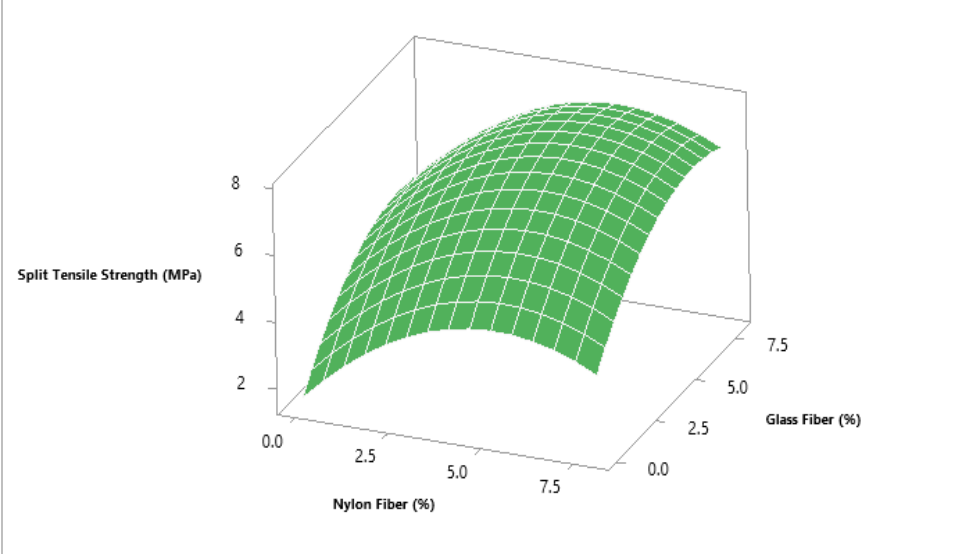
Figure 10. Three-dimensional response surface for flexural strength.